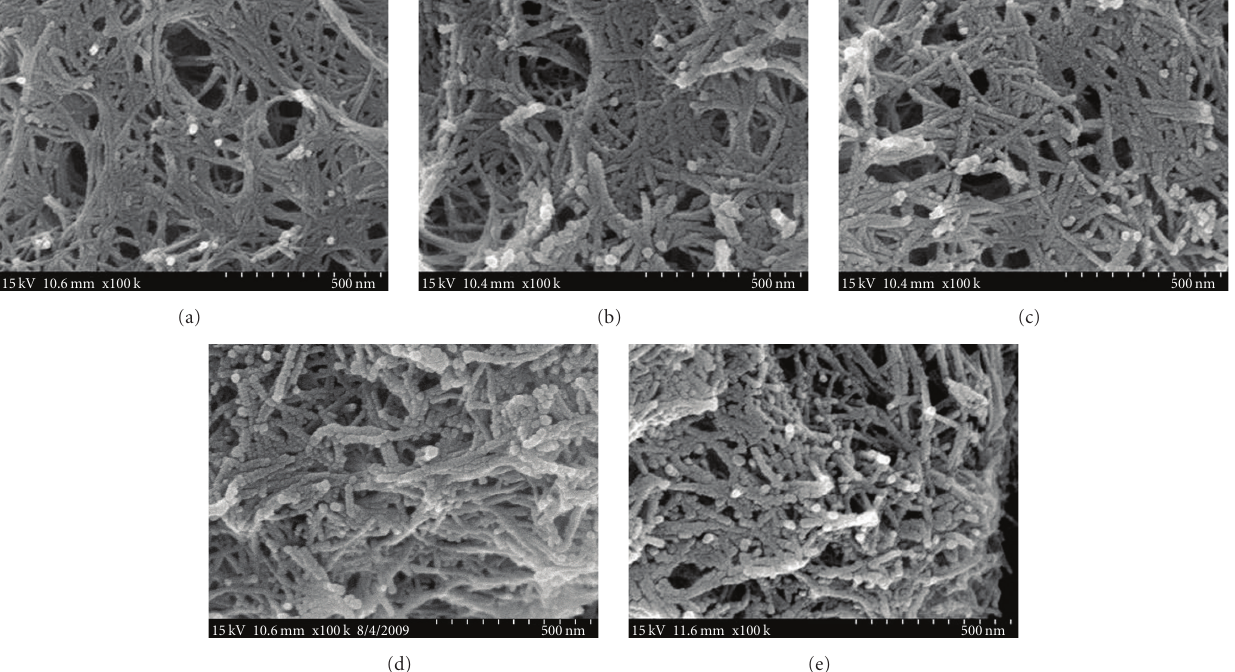
Figure 2: Scanning electron microscope images for the calcined powders at (a) 400 ◦ C, (b) 425 ◦ C, (c) 450 ◦ C, (d) 475 ◦ C, and (e) 500 ◦ C in O 2 atmosphere for 30min.